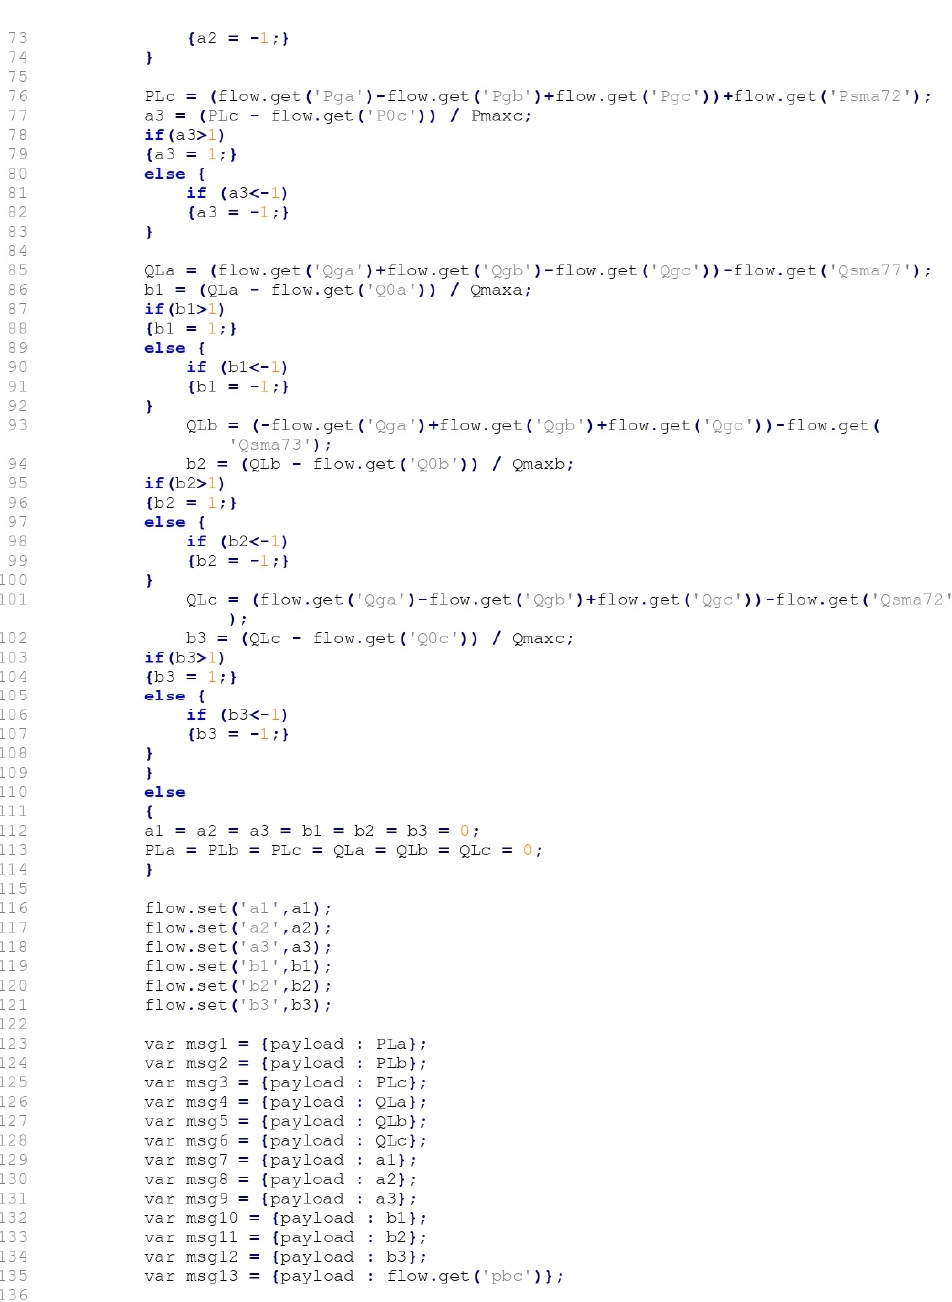
Figure A2. Part 2 of the MPBC algorithm developed in the Node-RED tool .